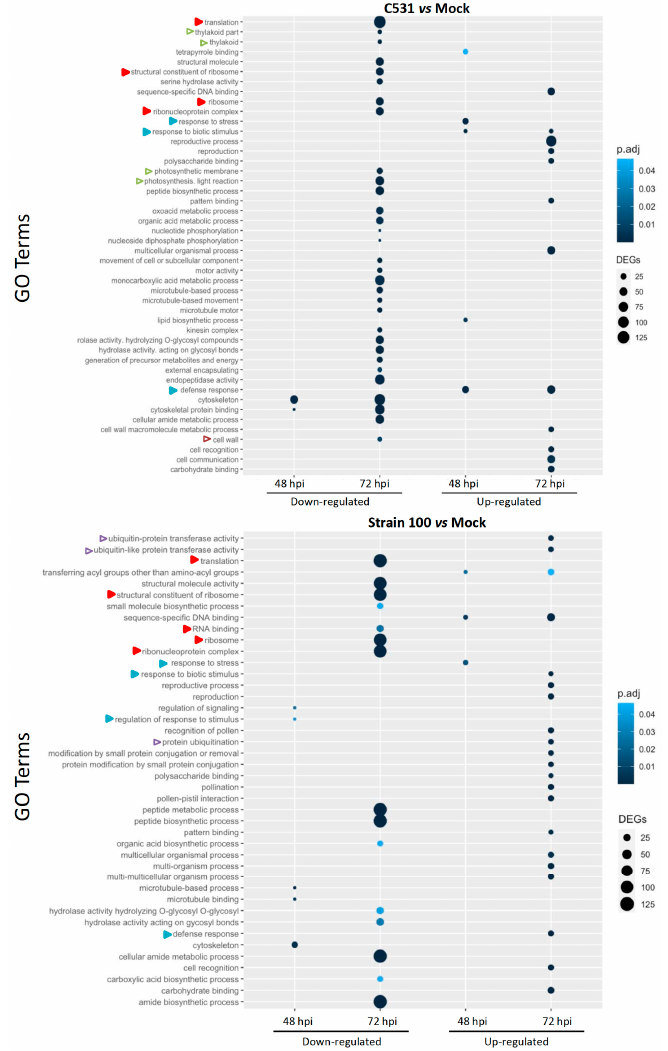
Figure 4. Gene Ontology enrichment analysis on DEGs from BAT93 plants, inoculated with C. lindemuthianum strain C531, incompatible interaction, or strain 100, compatible interaction, vs. Mock. Empty and full arrows represent enriched GOs that are specific to one infection condition or common between the two infection conditions, respectively. Color of the arrows represent different cellular processes: photosynthesis in green, translation in red, ubiquitination in purple, cell wall in brown and plant defense in blue.